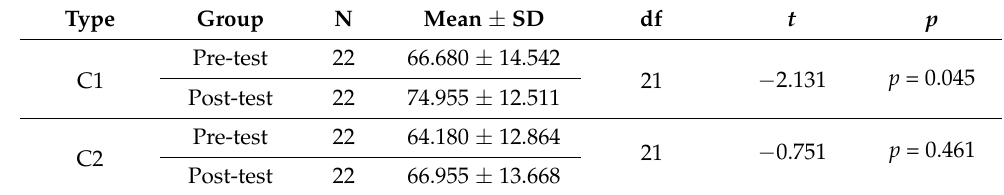
Table 4. Paired samples t -Test of the Pre- and Post-test Results for C1 and C2.